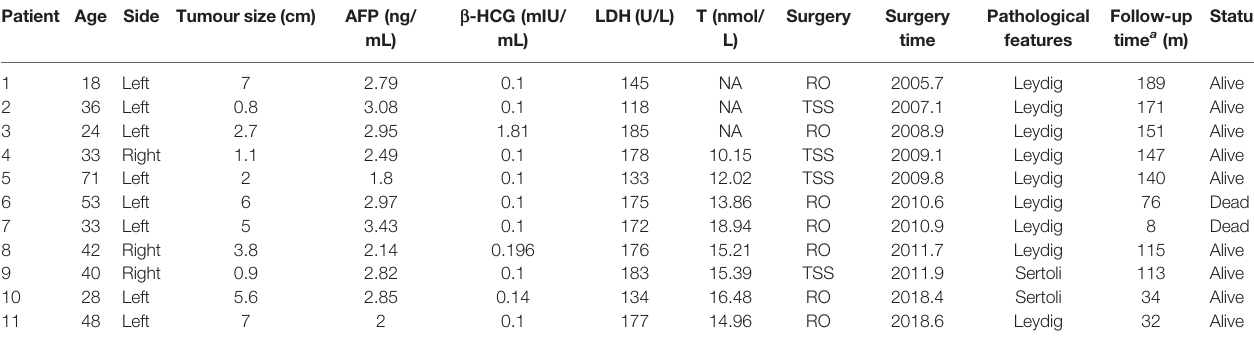
TABLE 1 | Clinical characteristics of 11 patients of testicular sex cord stromal tumours from January 2005 to January 2019. Patient Age Side Tumour